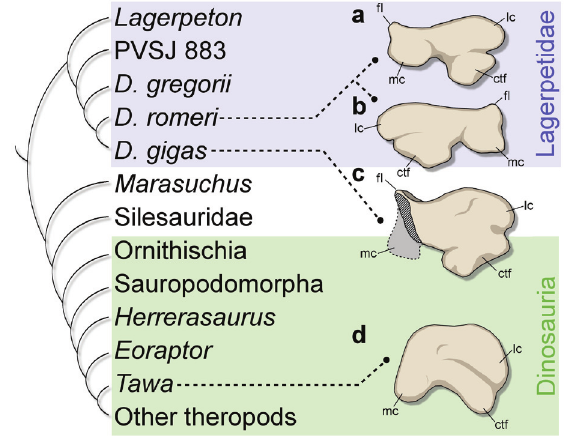
Figure 2 - Simplified phylogenetic relationships of basal dinosauromorphs based on a data set of Martínez et al. (2016) depicting position of lagerpetids and Tawa hallae . a , femur of GR 218 in distal view; b , femur of WTAMU-V-8301 in distal view; c , femur of PVSJ 898 in distal view; d , femur of GR 244 in distal view. Abbreviations: ctf, crista tibiofibularis; fl, flange; lc, lateral condyle; mc, medial condyle. Images not to